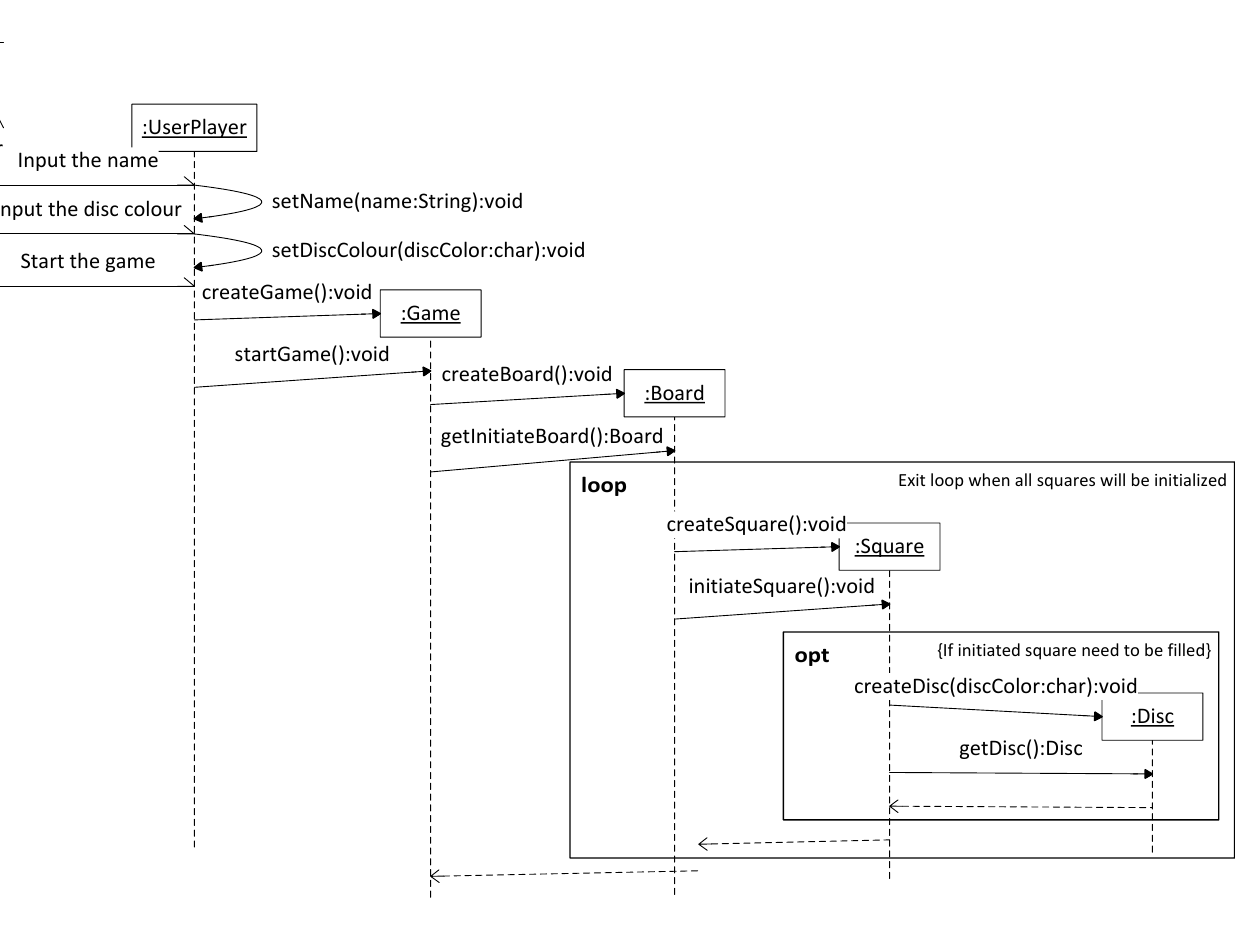
Fig. 2. The UML sequence diagram with the system goal “Start the game”.